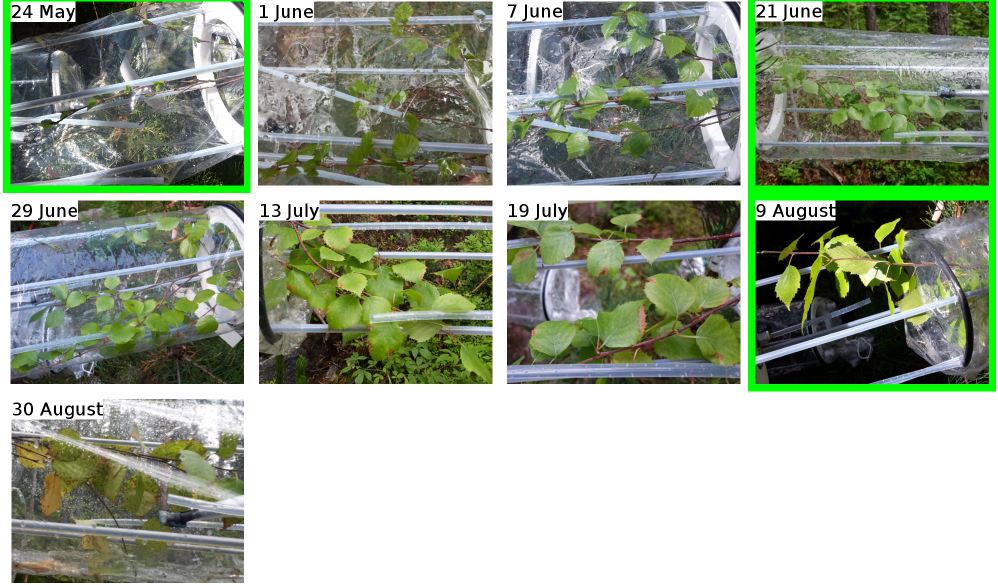
Figure A3. Pictures of birch branches. Dates framed in green indicate that a new branch was placed in the enclosure.